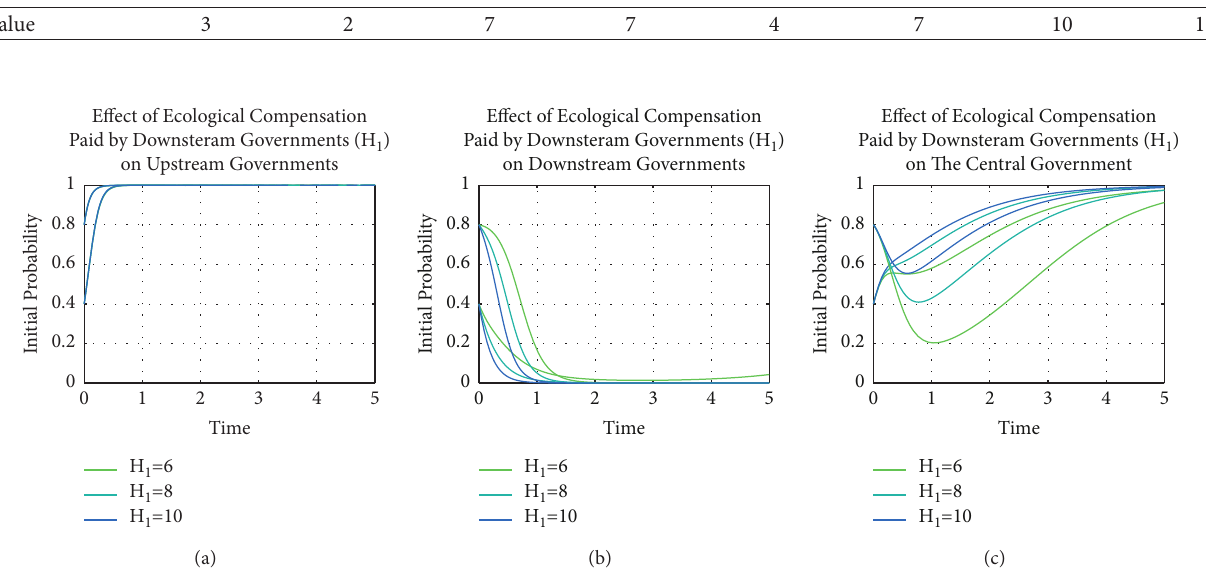
Table 8: The values of parameters in the simulation of ecological compensation paid by downstream governments ( H Parameter C 1